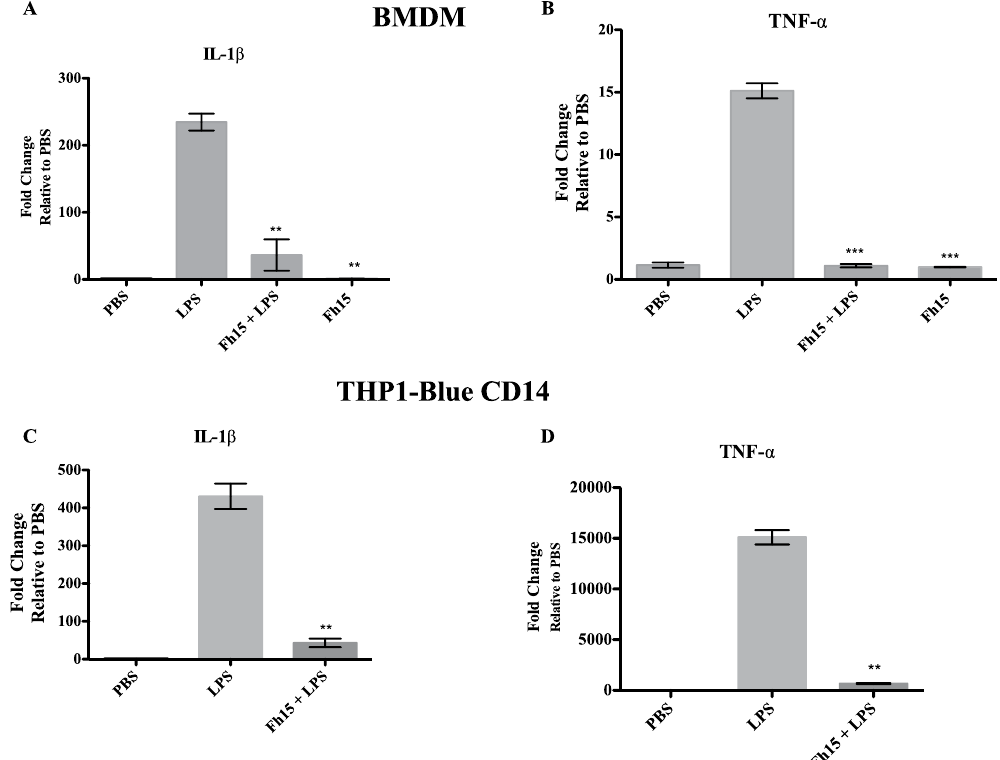
Figure 7. Fh15 suppressed the expression of TNF α and IL1 β cytokines from mouse BMDM and human monocyte cell line (THP1-Blue CD14) in response to LPS. Bone marrow derived macrophages (BMDM) from naive C57BL/6 mice and THP1-Blue CD14 cells were treated with 5 μ g/ml or 10 μ g/ml Fh15, respectively 30 min before stimulation with LPS (100ng/ml or 1 μ g/ml, respectively). Control cells were treated with LPS or PBS alone. After treatments cells were incubated by 18 h, at 37 °C 5% CO 2 . Expression of IL-1 β and TNF α was measured by real-time RT-PCR. Results shown are expressed as fold-changes in expression relative to cells stimulated with PBS and presented as mean ± SD of a minimum of three experiments, each in triplicate. ( A and C ) Fh15 significantly suppressed the expression of IL-1 β and TNF α and IL-1 β in murine BMDM ( ** p < 0.01 and *** p < 0.001), respectively. ( B and D ) Fh15 also significantly suppressed the expression of IL-1 β and TNF α in THP1 Blue-CD14 cells.